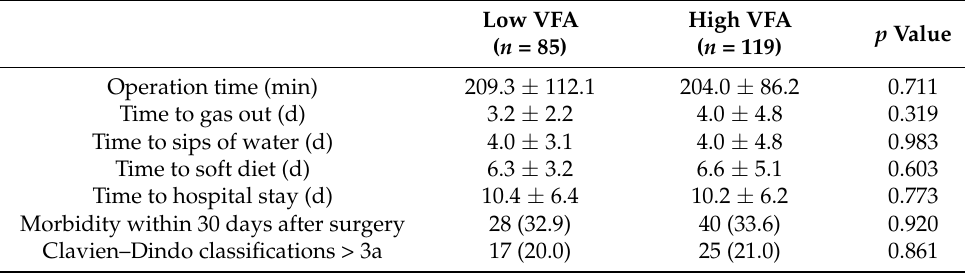
Table 2. Perioperative Clinical